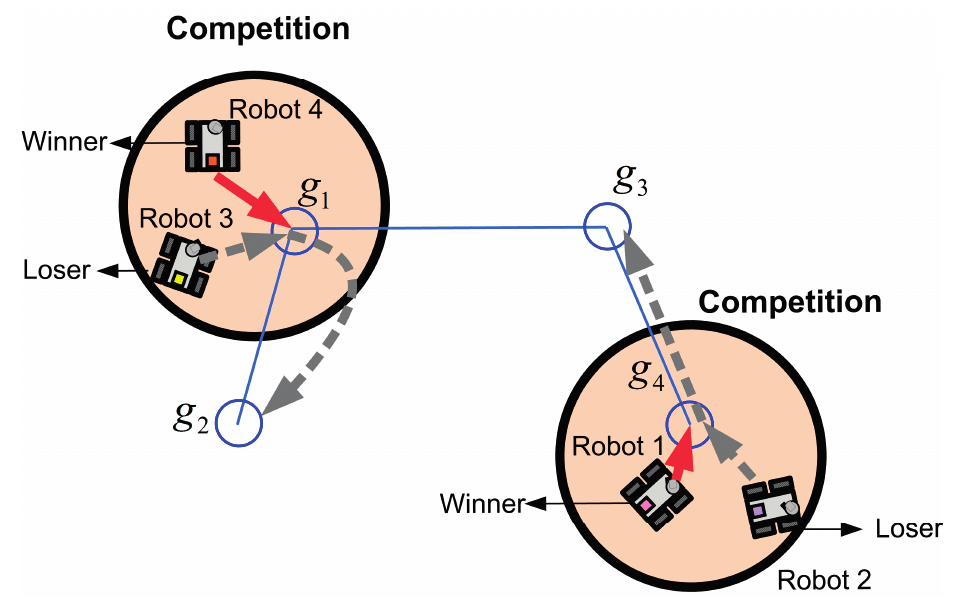
Figure 4. The competition of the followers for their